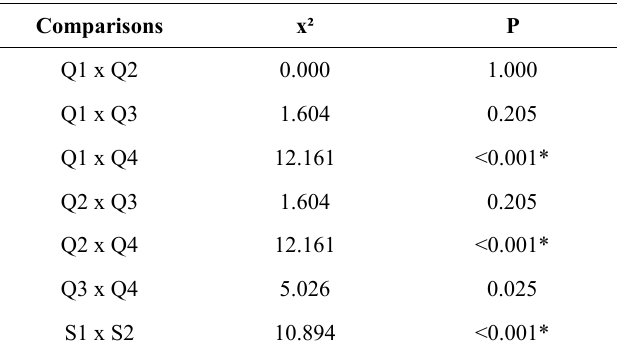
Table 2 – Values of Chi-square and significance level for comparisons related to birthdates